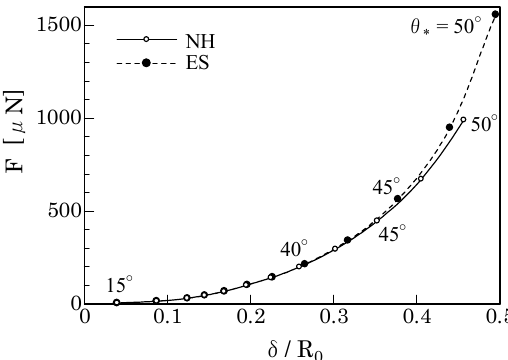
Fig.5 Comparison of the calculation results for the NH and ES materials The transmural pressure as a function of the non-dimensional displacement for the NH and ES materials is shown in Fig. 6. The difference between the NH and ES materials follows a similar trend to that in Fig. 5. The transmural pressure is important not only for preservation of the microcapsule shape but also for the release of the encapsulated solutions. The volume flux of the liquid across the membrane is calculated from the product of the transmural pressure and the permeability of the membrane (13) . Therefore, the results in Fig. 6 are crucial for controlling drug release in drug delivery systems.